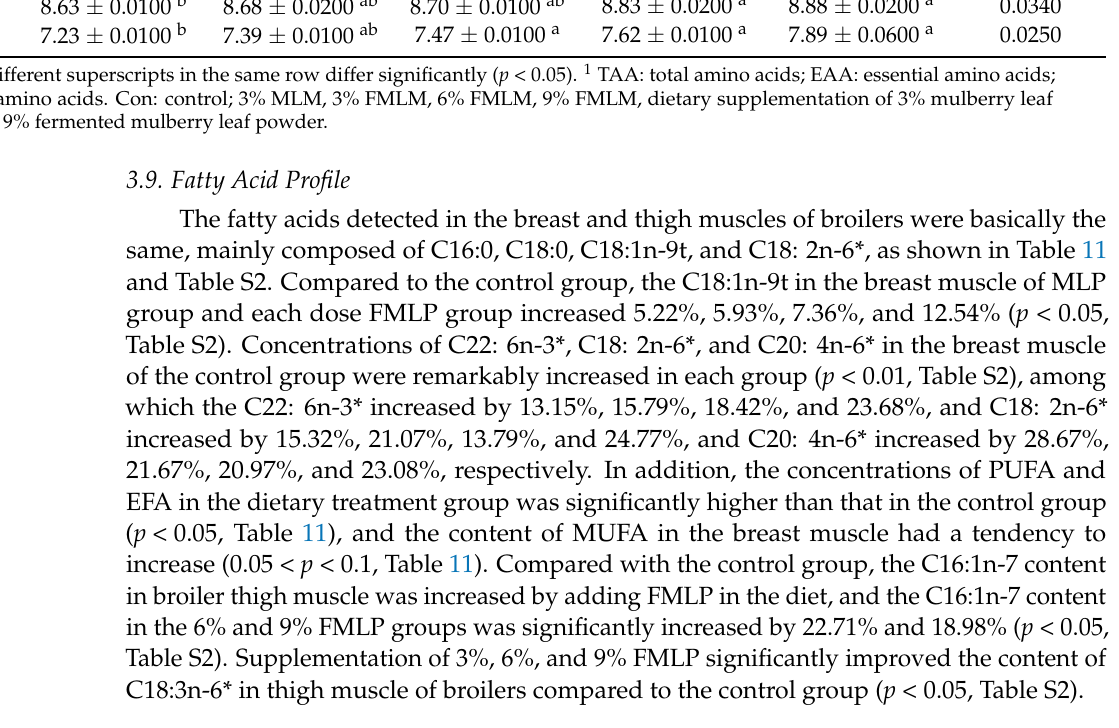
Table 11. Effects of FMLP on fatty acid profile in breast and thigh muscle of